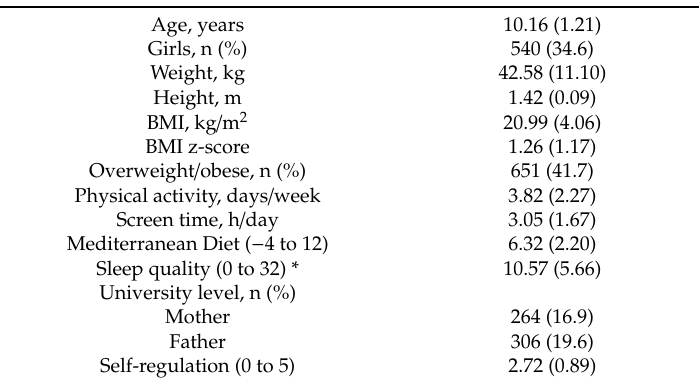
Table 1. Participants’ characteristics ( n = 1,561).